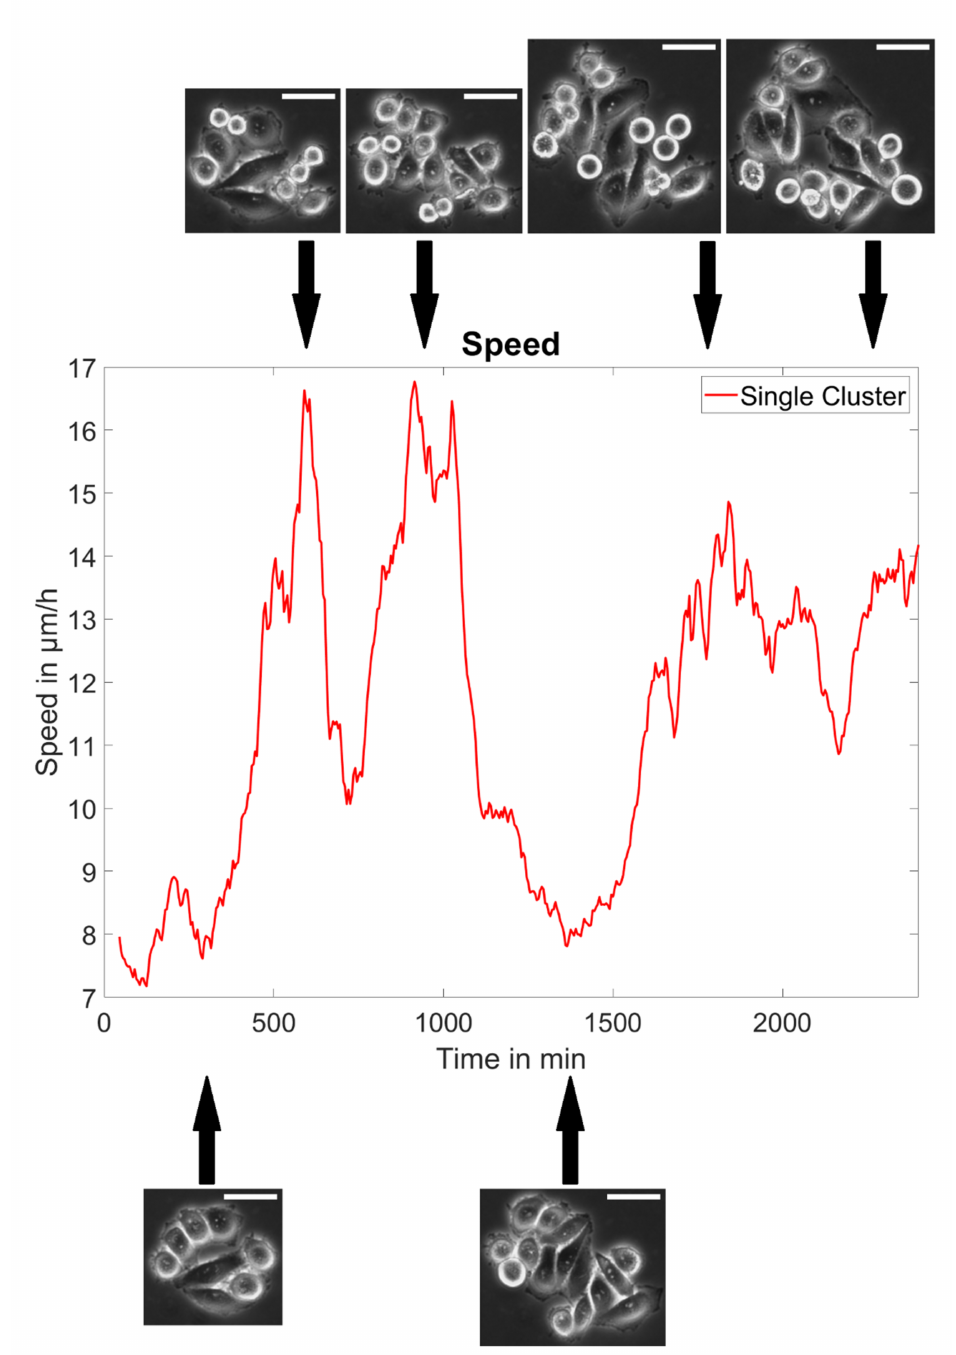
Figure A4. Plot of the smoothed cellular speed inside one representative cluster of SW480 \ EV cells together with some example images associated with peaks and dips. The curve was smoothed with a moving average filter of size 15. Please note the high number of cells showing the characteristic mitotic rounding at peaks (top images) and their absence in dips (bottom images). The scale bar corresponds to 50 µ